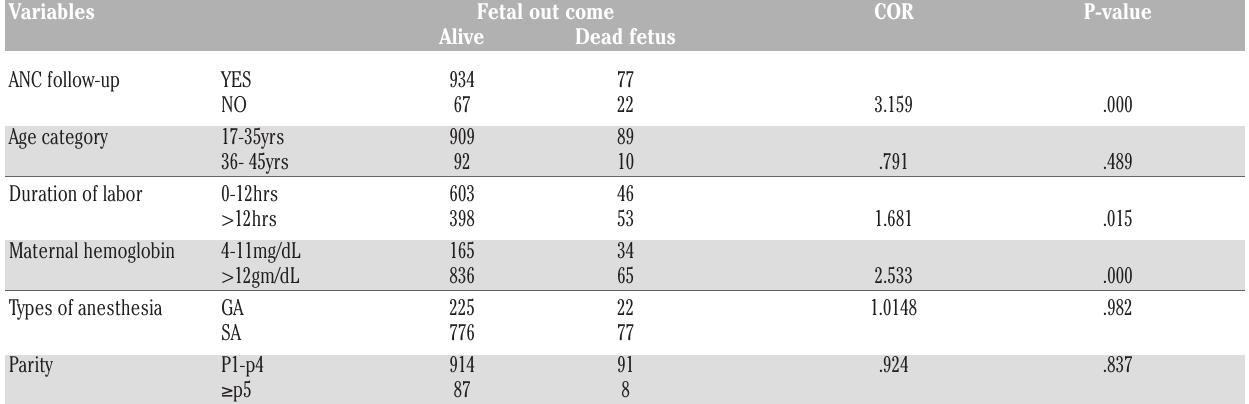
Table 8. Shows factors associated with fetal outcome at DBRH from January, 2015 to December,